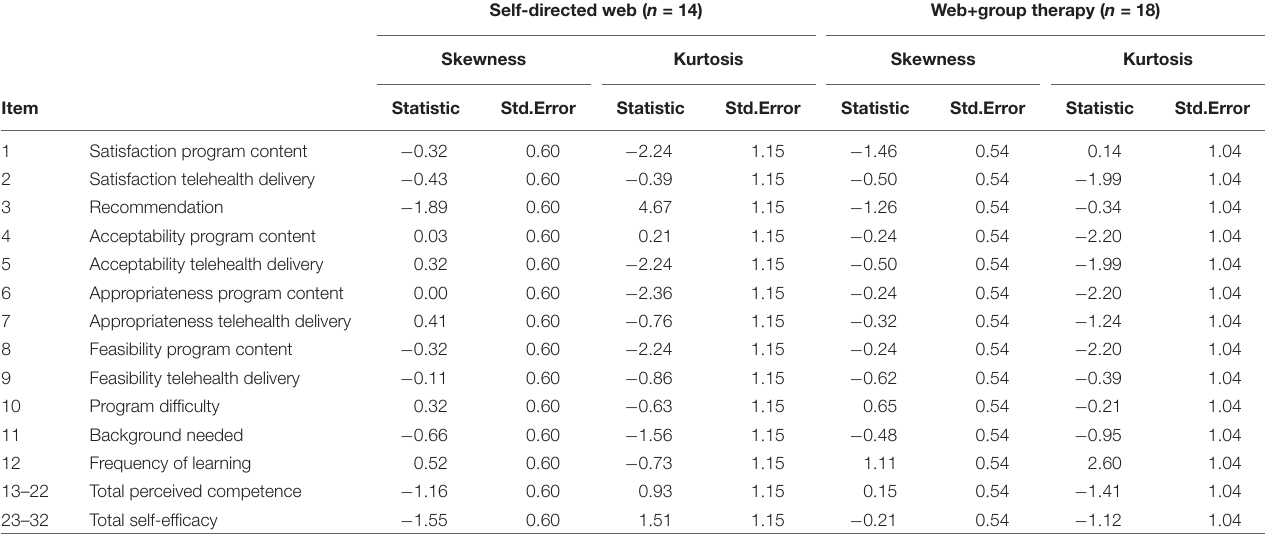
TABLE 4 | The skewness and Kurtosis of items in program evaluation survey ( N = 32).